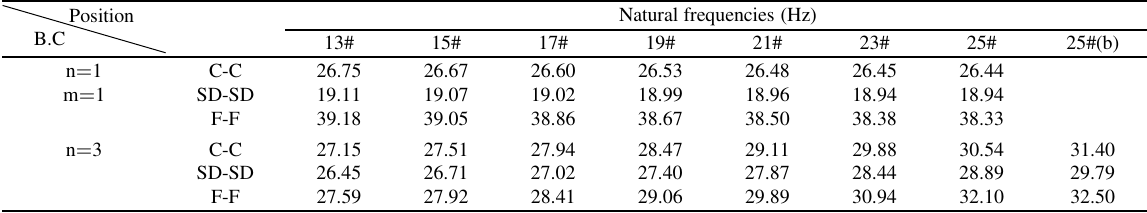
Table 7 Natural frequencies of cylindrical shells with different positions of frame